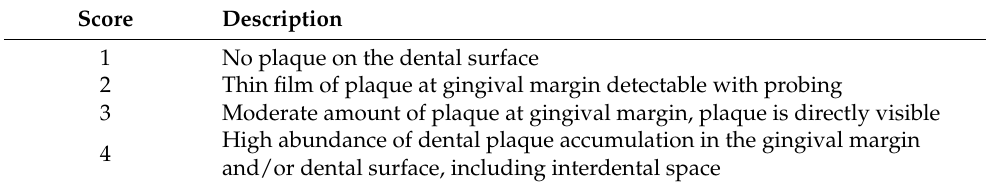
Table 2. Dental plaque index (DPI) based on Holmstrom et al. [16]. Score Description